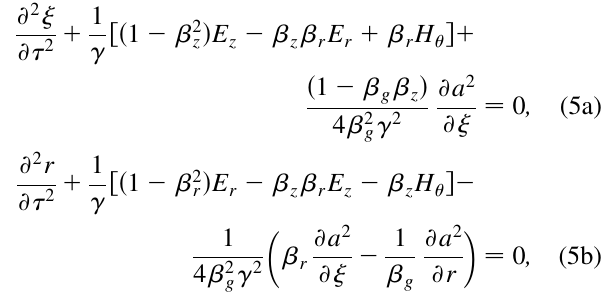
FIG. 2. (Color) The laser wakefield generated in a plasma (a) and transverse channel. The normalized longitudinal E z (cid:2) (cid:22) (cid:4) E H f (b) components of the wakefield. a r g (cid:25) r (cid:2) 2 , (cid:31) (cid:2) 2 : 5 , and (cid:9) (cid:2) (cid:4) 3 (cid:31) (cid:31) z r c z